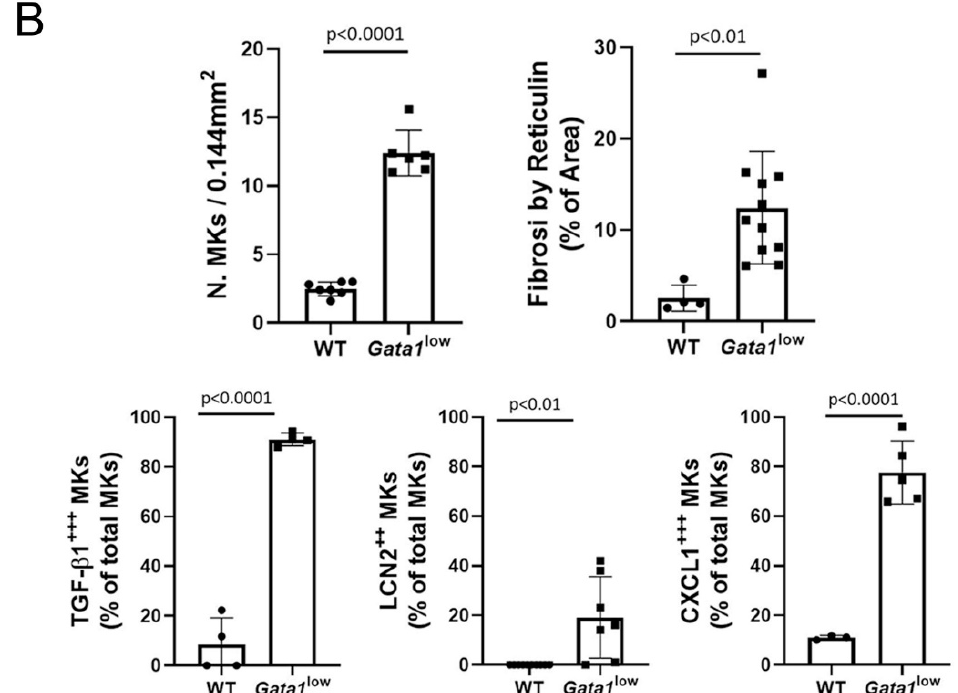
Figure 5. Megakaryocytes from the bone marrow of Gata1 low mice contain more TGF- β 1, LCN2, and CXCL1 than the corresponding cells from the wild-type littermates. ( A ) Representative sections from the bone marrow of wild-type and Gata1 low littermates immunostained with antibodies per TGF- β 1, LCN2, and CXCL1 showing the level of these cytokines in endothelial cells, osteoblasts, megakaryocytes, and neutrophils (all indicated by arrows) recognized by morphological criteria as indicated. Semiquantitative estimates ( − , +, ++, or +++) of the intensity of the staining in each population is indicated on the top left. Original magnification 40 × . Representative sections stained only with the primary antibody are shown in Figure S6 (Supplementary Materials) as negative controls. ( B ) Quantification of TGF- β 1, LCN2, and CXCL1 expressing MKs of wild-type and Gata1 low mice. Frequency of total megakaryocytes, levels of fibrosis (as control), and percent of megakaryocytes expressing high levels of TGF- β 1, LCN2, and CXCL1 in bone marrow section from Gata1 low and wild- type littermates, as indicated. The content of proinflammatory cytokines in the megakaryocytes was quantified as described in Figure S2 (Supplementary Materials) using five randomly selected areas per femur from three–four mice per experimental group. Statistical analysis was performed by t -test, and statistically significant p values among groups are indicated within the panels.